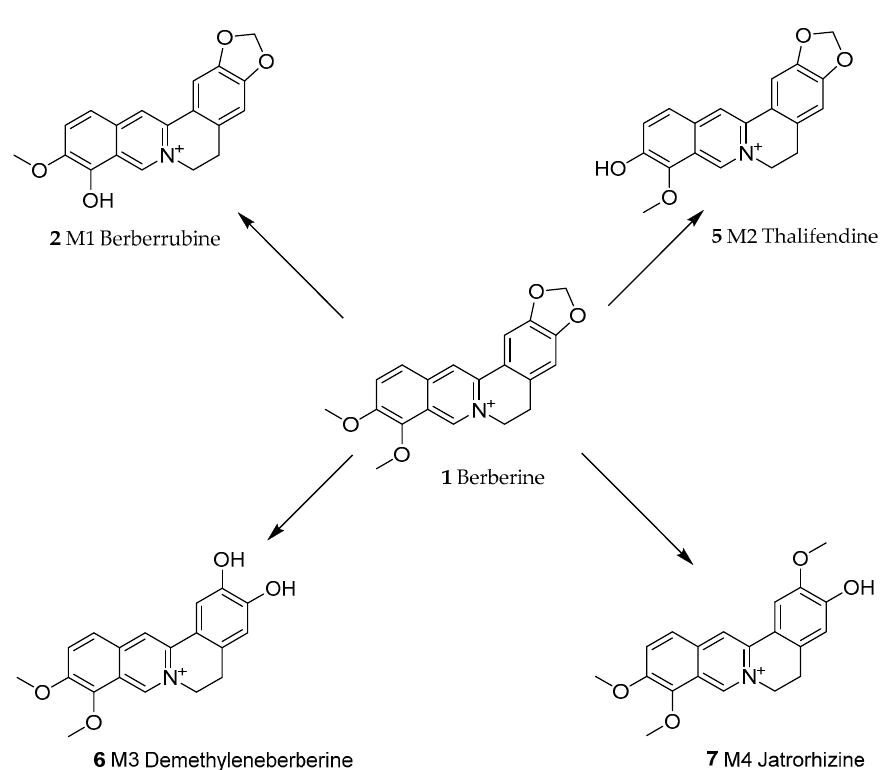
Figure 2. Phase-I transformation of berberine by CYP450 (Cytochrome P450) in liver cells [38]. CYP2D6 and CYP1A2 play a major role in transforming berberine into M2; CYP2D6, CYP1A2 and CYP3A4 are key to M3 production. M1 and M4 could be below detection level.